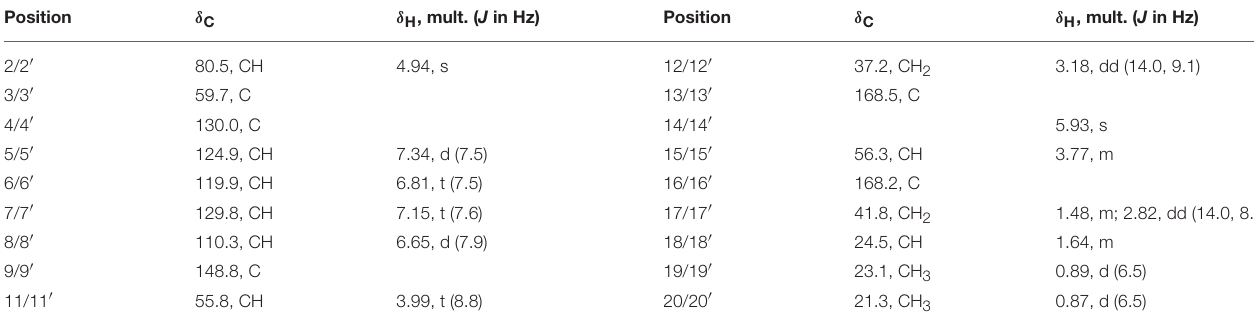
TABLE 3 | 1 H (600 MHz) and 13 C NMR (150 MHz) Data for 3 in CDCl 3